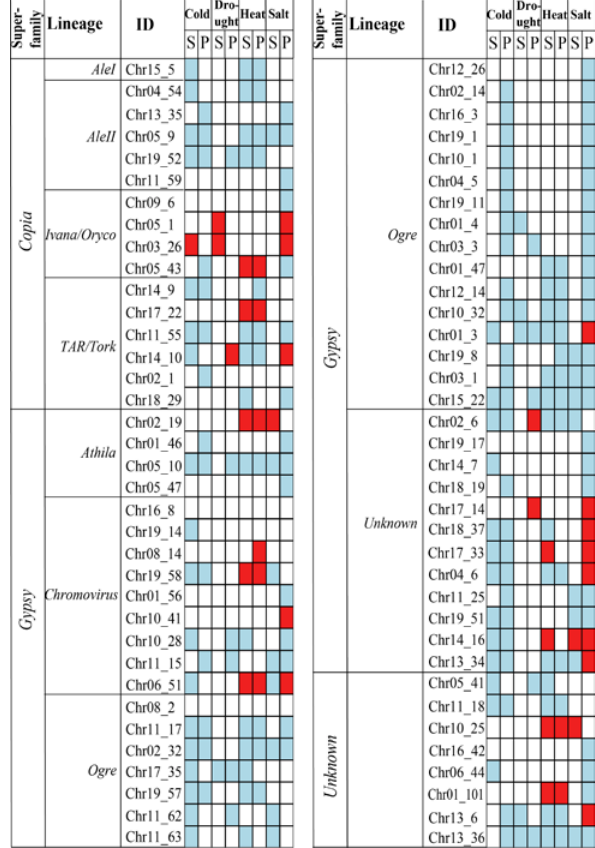
Fig. 7. Differential expression (fold change > 2, FDR-corrected p < 0.05) of LTR-REs after short (S) or prolonged (P) treatments with different stresses compared to controls. Blue cells refer to under- expression, red cells to over-expression, white cells indicate no effect of the treatment in comparison to